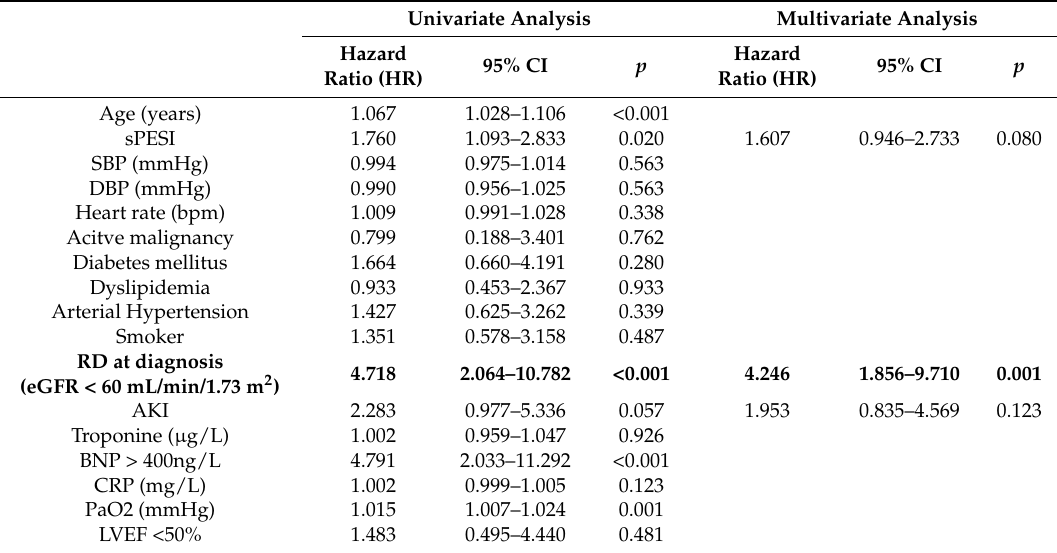
Table 5. Univariate and multivariate analyses for the prediction of cardiovascular mortality.